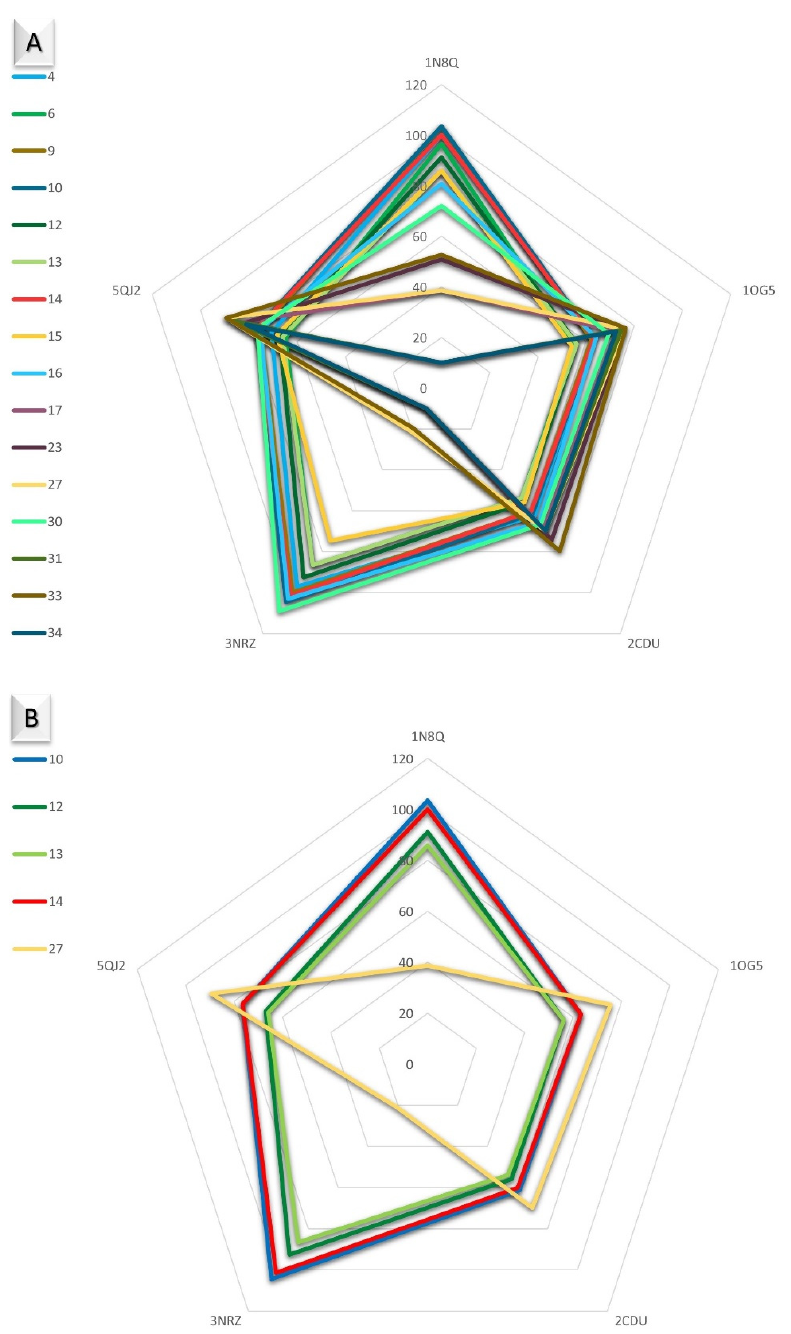
Figure 2. Graphical representation of docking scores related to antioxidant protein targets, corresponding to the components above 1% of the OEO content ( A ) and OEO constituents above 5% of the OEO content ( B ) (representing above 65% of the volatile oil); lines are generated for each compound based on the docking scores calculated for each target protein as a percentage of the NL’s docking score used as the positive control (100%); the lines and are plotted as series in a radar chart, where the proteins represent the corners of the chart.